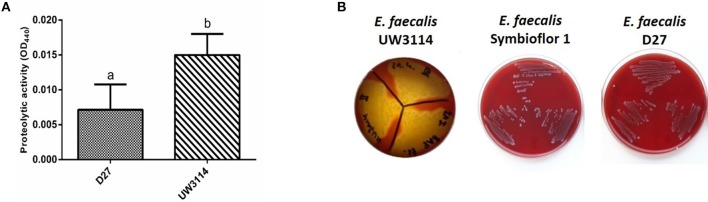
(A) proteolytic activity, measured as optical density (OD) at 440 nm, in E. faecalis D27 and E. faecalis UW3114; (B) hemolytic activity of E. faecalis UW3114, Symbioflor 1 and D27 tested on horse blood agar plates. Only E. faecalis UW3114 shows β-hemolytic activity.